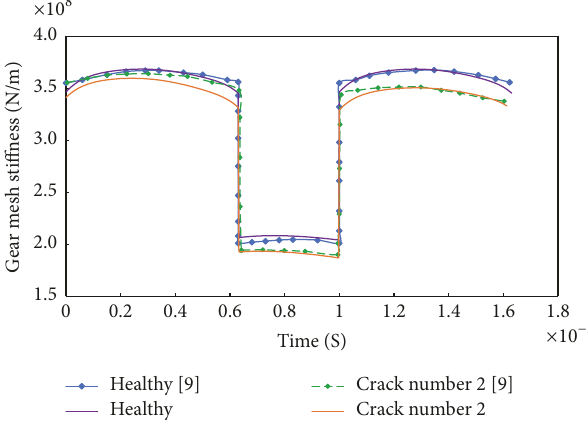
Figure 14: Comparison of the mesh stiffness for a healthy and a cracked pinion with [9].